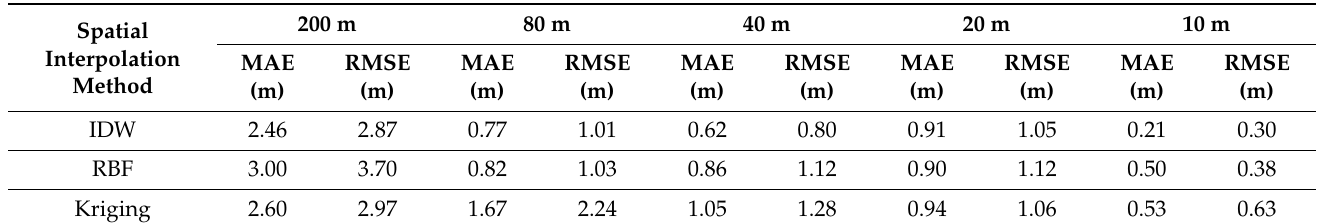
Table 1. The impact of section spacing on the spatial modeling results of underwater